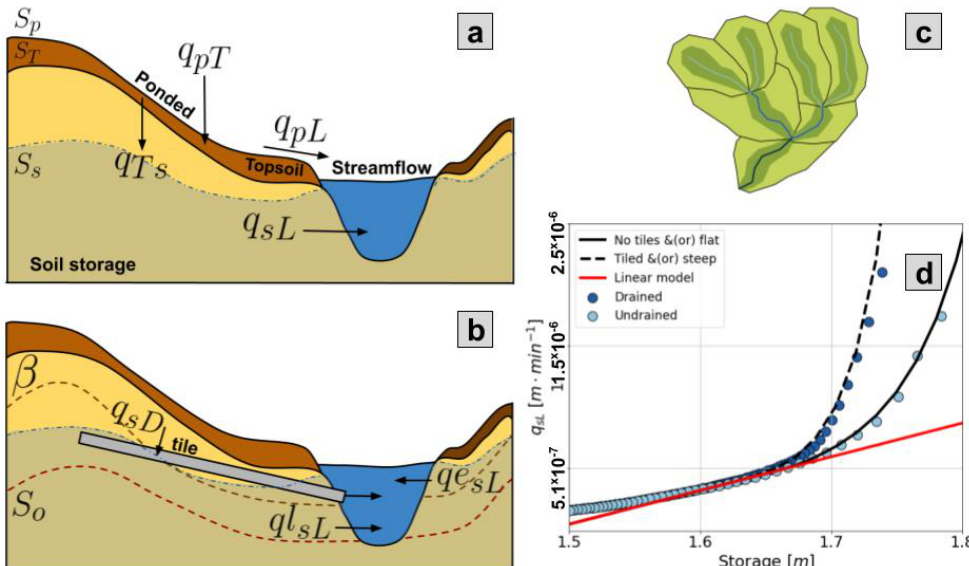
Figure 2. Hillslope Link Model spatial discretization and schematic of the storages and processes represented at the hillslope scale: ( a ) HLM hillslope process using the linear subsurface flux equation; ( b ) hillslope process including the active layer ( β ), the exponential flux ( qe sL ), and the tile drainage flux ( q sD ); ( c ) watershed decomposition into hillslopes and channel links; and ( d ) functional form of the subsurface flux in the function of the soil storage ( S s ) after